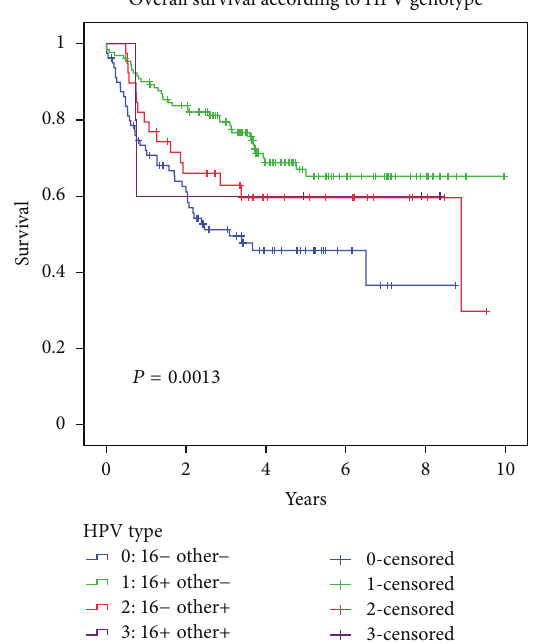
Figure 5: Overall survival according to HPV genotype.